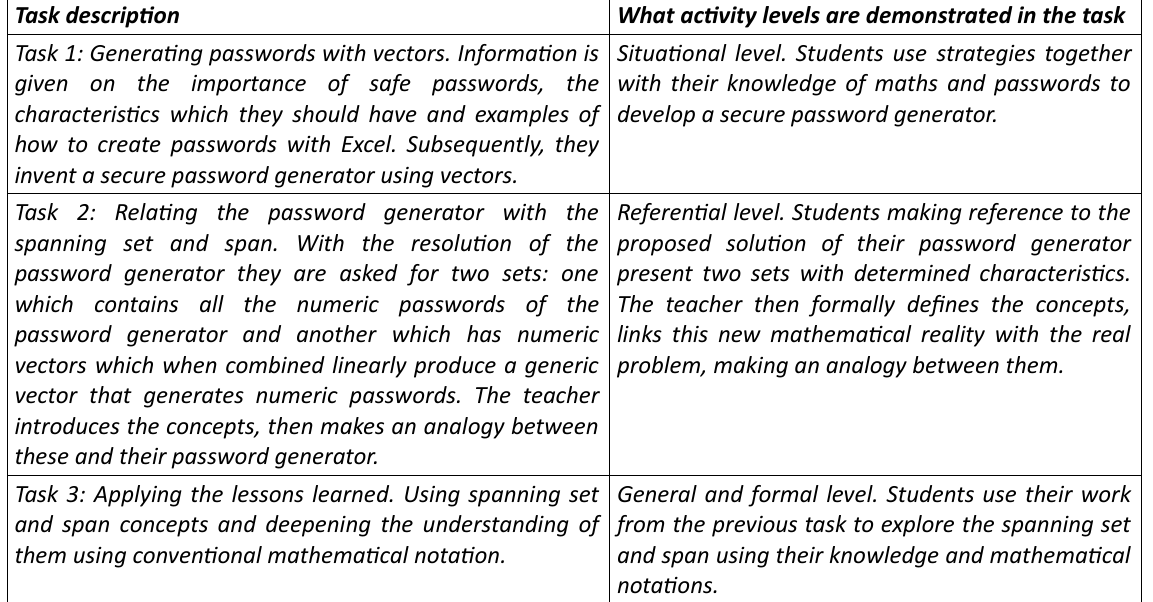
Table 1. Description of tasks from the instructional design and relationship with activity